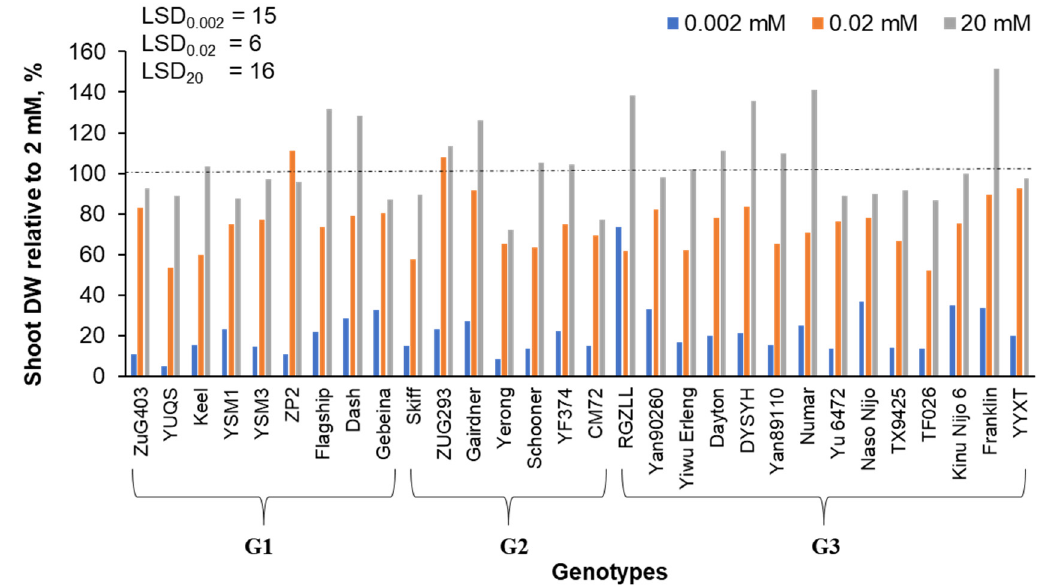
Figure 3. Relative shoot dry weight of 30 barley genotypes grown at different K levels (0.002 mM, 0.02 mM and 20 mM) as compared to optimal 2 mM treatment. Genotypes were divided into three groups G1, G2 and G3 (see Figure 1 for details) produced by cluster analysis. Data are means ± SE (n = 6). LSD are based on significance at p < 0.05 level. Table 3. Genotypic variation in the shoot dry weight g/plant of barley genotypes under different concentration of K + supply. Values are mean ± SE (n = 6) and G represents different groups of gen- otypes. Genotypes have been divided into three group G1, G2 and G3 according to cluster analysis